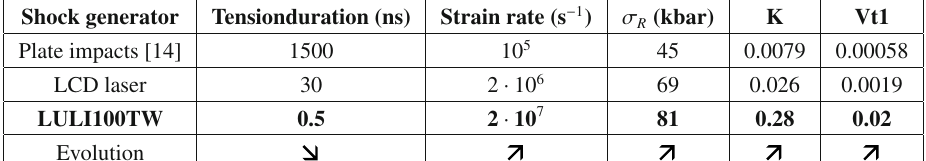
Table 2. Tantalum Kanel damage parameters fitted for di ff erent shock generators / strain rates.